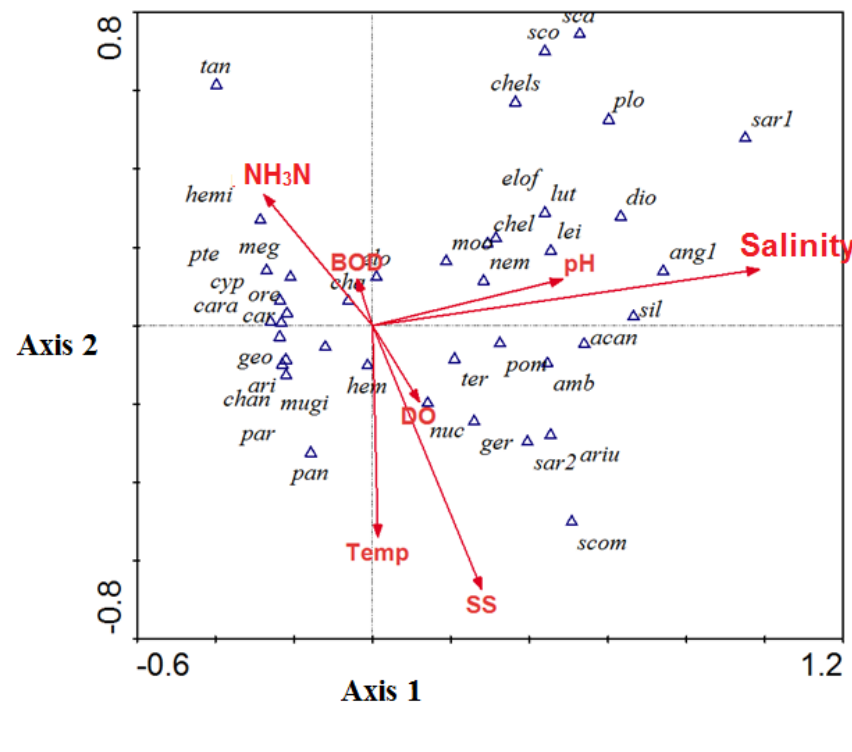
Figure 5. The environmental factors loading and their correlation to fish taxa of the Tanshui River system. Sampling sites were located in the downstream area and were affected by tidal movement in 2012. Plot based on the regression on factors 1 and 2. The abbreviations used in this picture are listed in Table